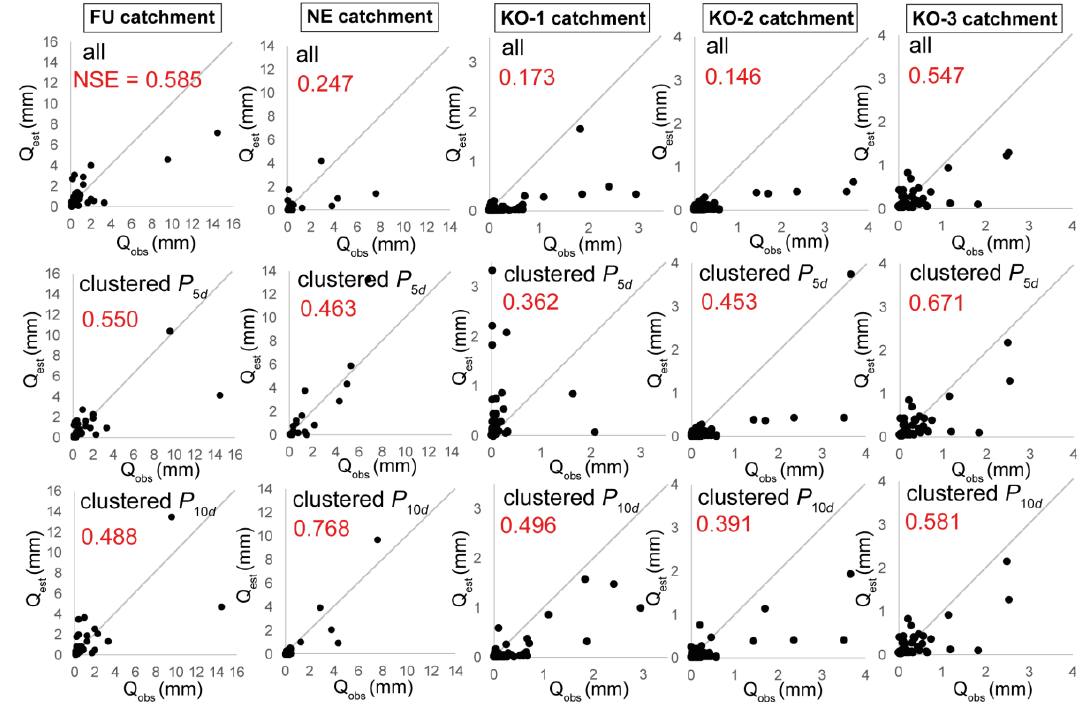
Figure 7. Comparison of observed direct runoff heights with those simulated using pairs of S and λ identified by means of model fitting procedure. The validation was carried out both with (all) and without delimitation of clusters according to P 5 d (clustered P 5 d ) and P 10 d (clustered P 10 d ).